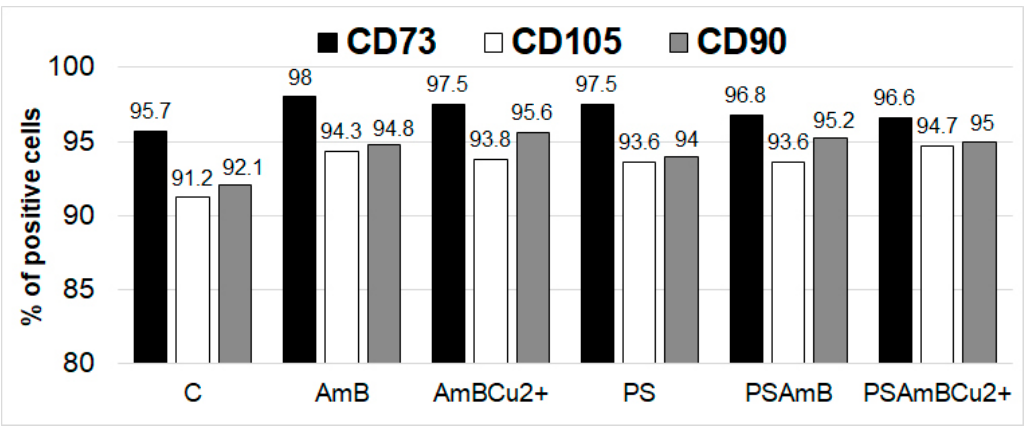
Figure 4. The percentage of positive cells for CD73, CD90 and CD105 markers after treatment with tested antibiotic and their combinations (FACS analysis).